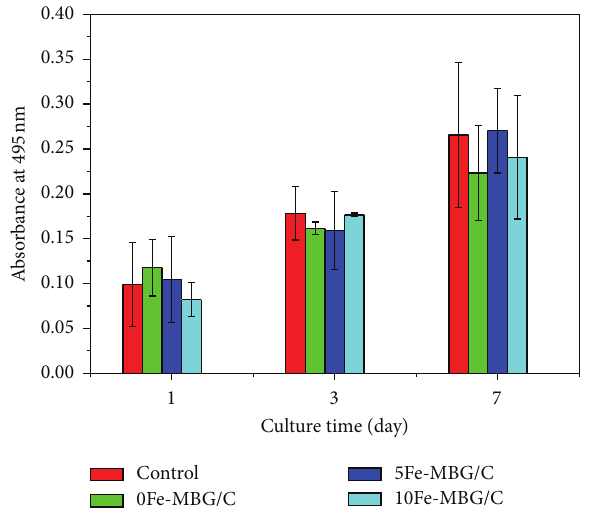
Figure 9: The cytotoxicities of the Fe-MBG/C composite scaffolds evaluated by MTT assay.